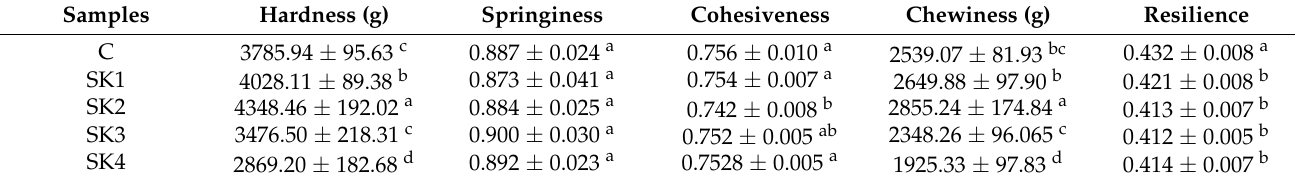
Table 2. Texture profile analysis (TPA) of surimi gels with different KEH.